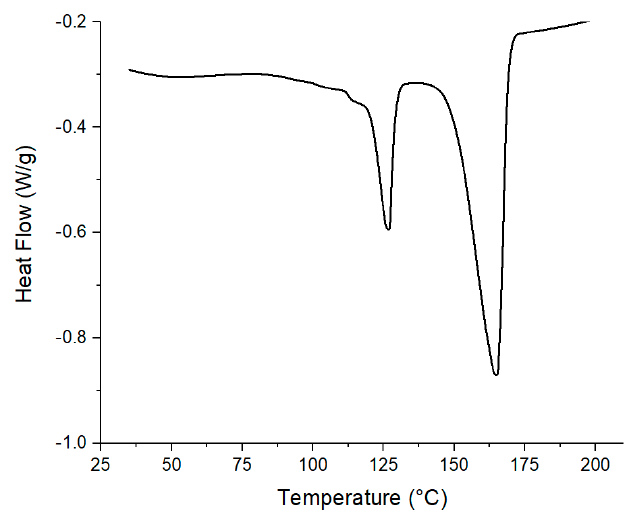
Figure 1. Differential scanning calorimetry (DSC) thermogram of neat polypropylene (PP) (exo up). Figure 2 reports the TGA and DTG curves of neat PP, obtained both in air and nitrogen. In both cases, PP shows no significant residue and a single DTG peak, which is higher in inert than in oxidative atmosphere (air: 382 °C; nitrogen: 450 °C). This result is consistent with the one that can be obtained with a typical PP, without significant differences that could have been attributed to the eventual presence of metals.